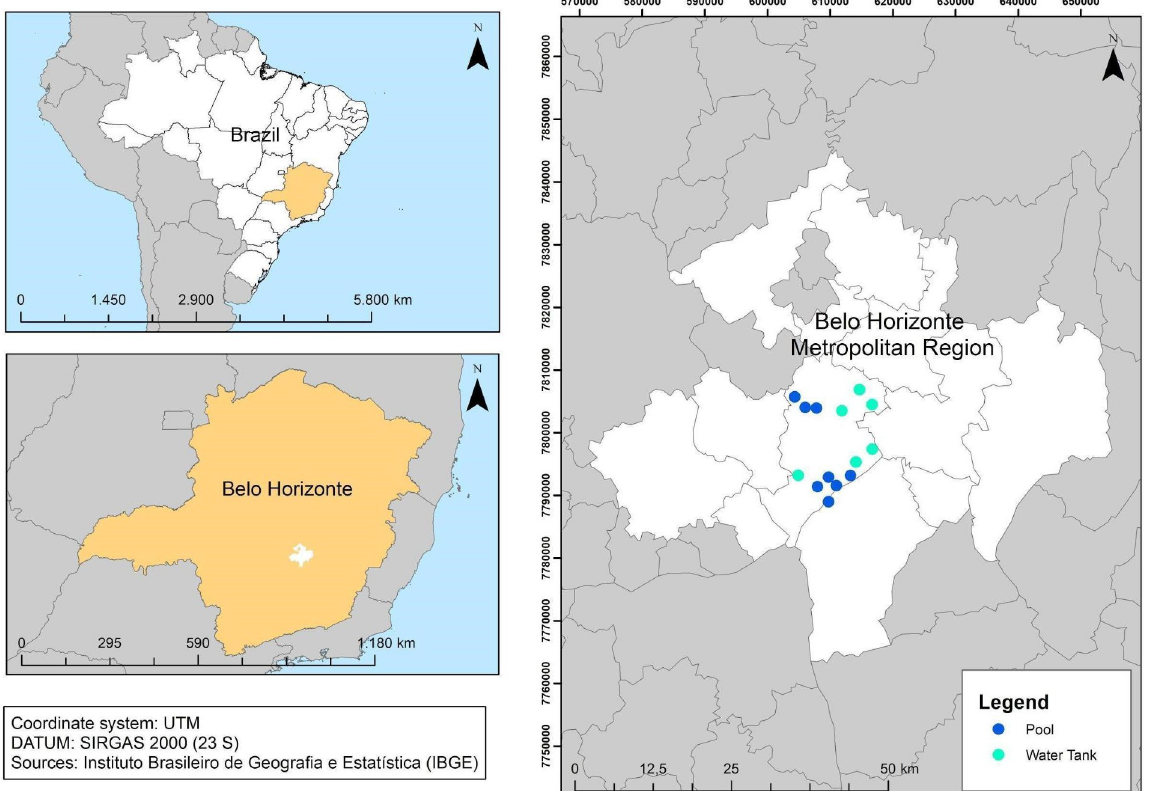
Fig 1. City of Belo Horizonte with the neighborhoods used in the